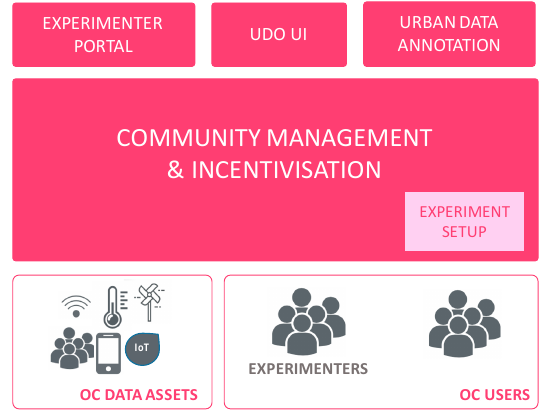
Figure 8. Interactions between various system components and the Community Management & Incentivisation component.